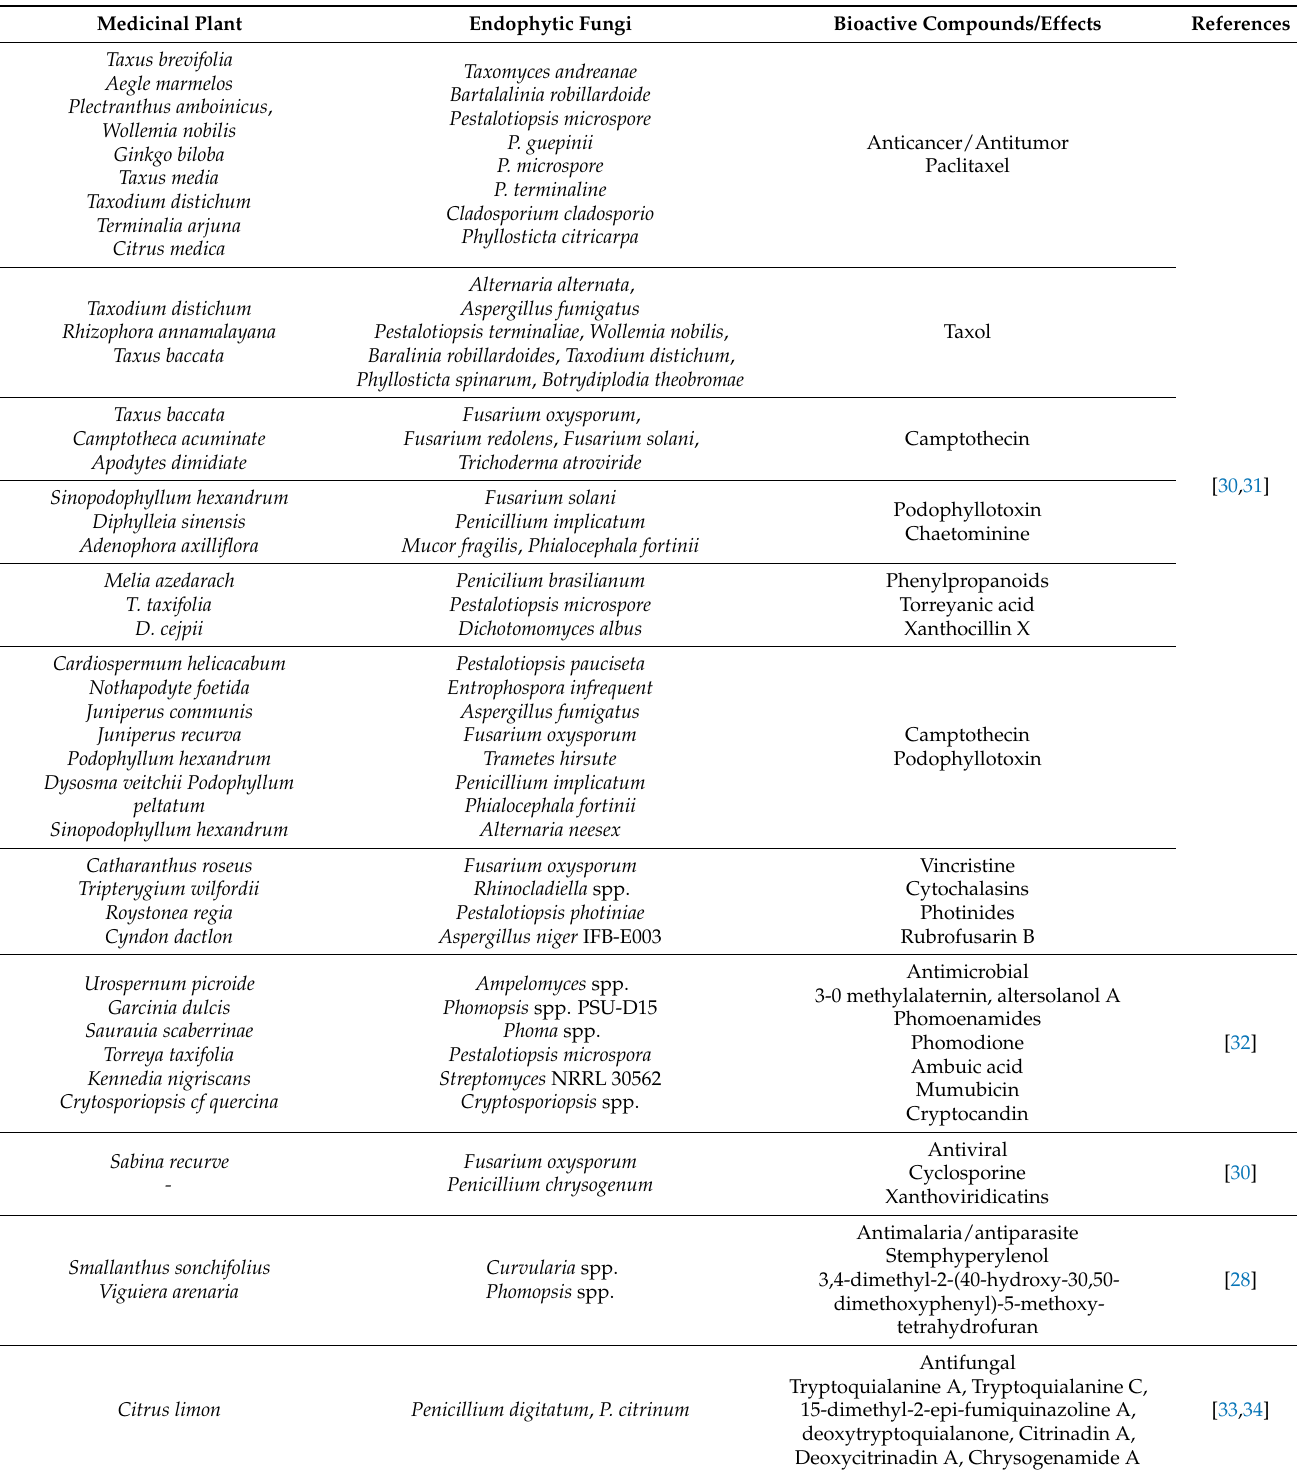
Table 1. The effects of bioactive compounds of fungal endophytes associated with medicinal